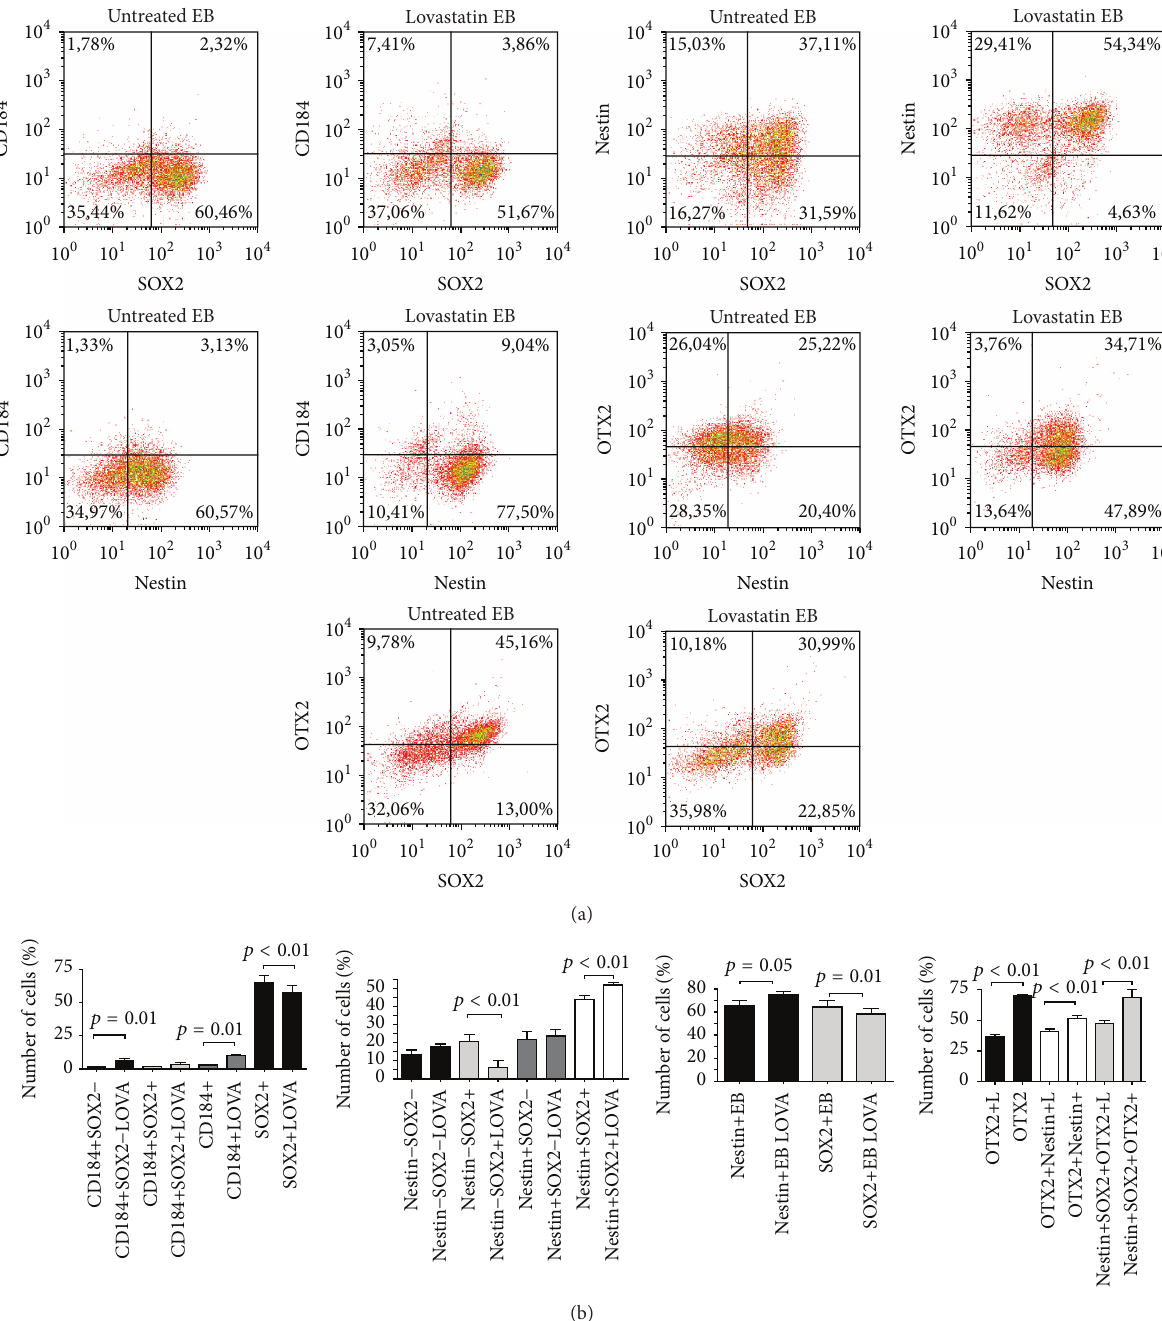
Figure3: Characterization ofuntreated andlovastatin treated EBcells forectodermal differentiation markers.(a)Singlecell suspensionsfrom EB were analysed for the expression of CD184 (CXCR4), nestin, SOX2, and OTX2. (b) The mean number of cells ± SD ( 𝑛 = 4 ) expressing the